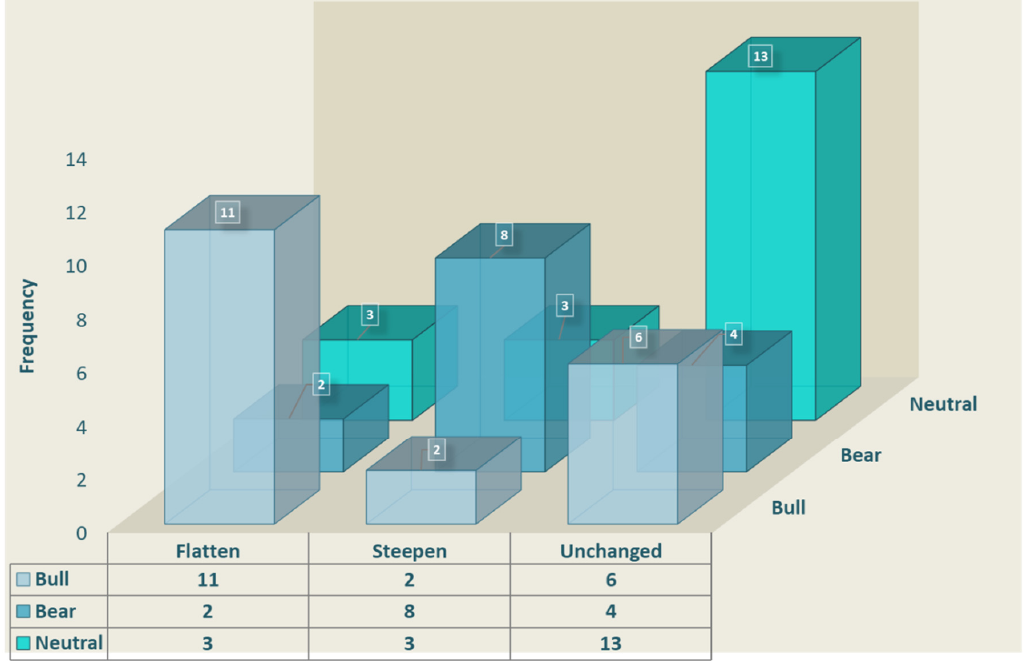
Figure 9. Weekly yield curve patterns on 28 February 2020 (last 52 weeks). Source: Bloomberg yields, own computation of yield curve